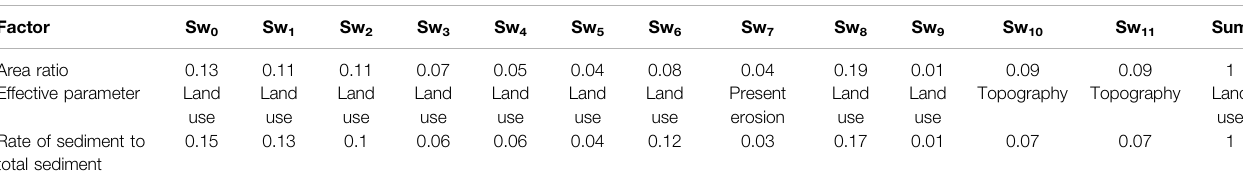
TABLE 9 | Results of comparing different factors in Anzali catchment